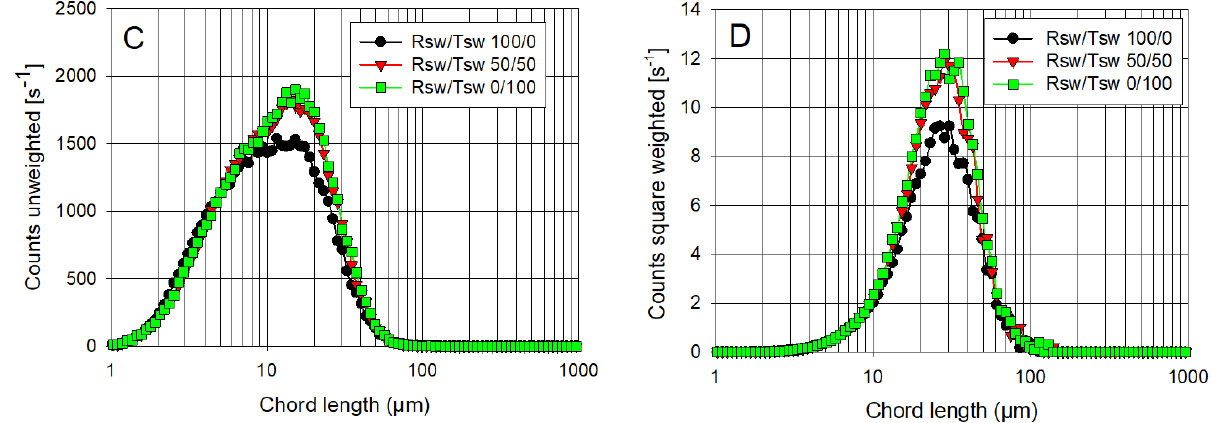
Figure 6. Unweighted and square-weighted chord length distributions (CLD) for unflocculated slurries. ( A , B ): Qz/Kao 90/10; ( C , D ): Qz/Kao 75/25.